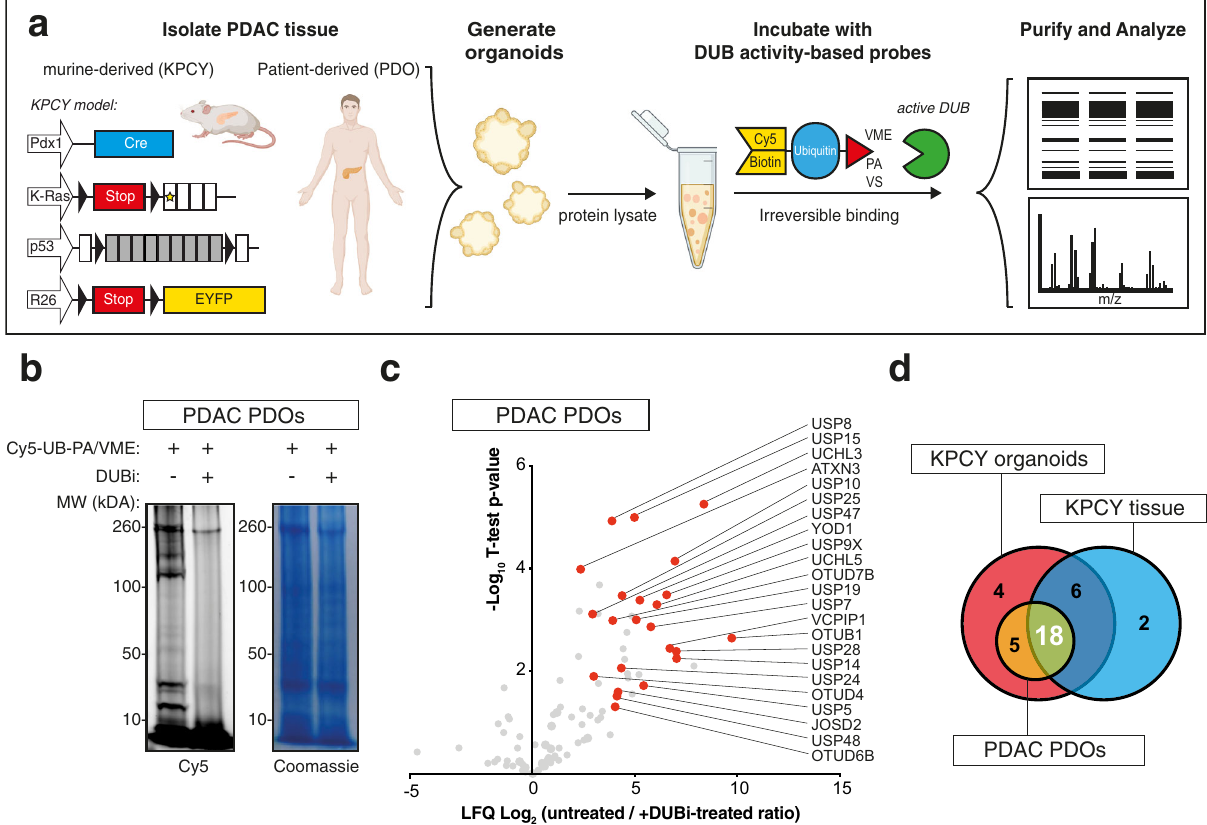
Fig. 1 Characterization of PDAC speci fi c DUBs using activity-based-probe proteomics. a Schematic overview of ABP experiment performed in PDAC organoids, created with BioRender.com. b In-gel visualization of Cy5-Ub-ABP labeled DUBs in patient-derived organoids (PDO). c Mass spectrometry analysis of DUBs labeled with Biotin-ubiquitin-ABP in PDOs. Volcano blot depicts the label-free quanti fi cation (LFQ) of − log 10 t-test p-value vs ratio difference of untreated (right side) and DUBi-treated (left side) samples. Gray dots indicate all proteins identi fi ed, and red dots highlight all signi fi cant DUBs. d Venn diagram summarizing identi fi ed DUBs, from mass spectrometry experiments comparing untreated vs DUBi-treated samples. Source data are provided as a Source Date fi